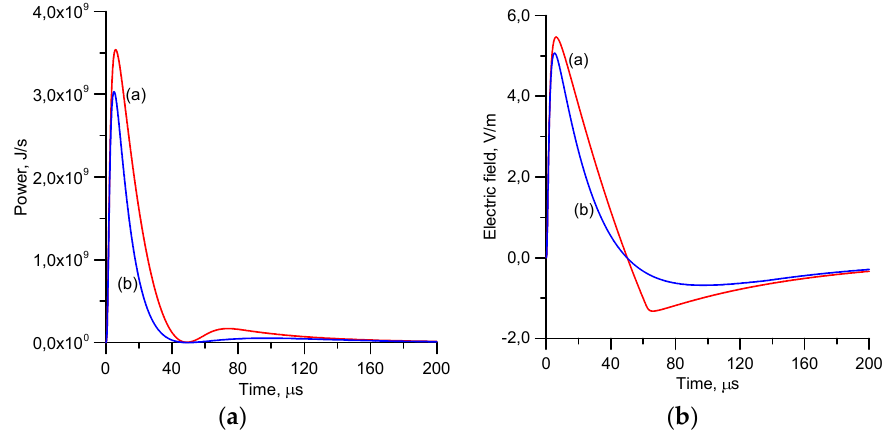
Figure 8. ( a ) Temporal variation of the radiated power as a function of time. Curve (a) MTLL model with a radiation field having 50 μ s zero-crossing time. Curve (b) MTLE model with a radiation field having 50 μ s zero-crossing time. ( b ) The electric field at 100 km at ground level corresponding to the power curves.